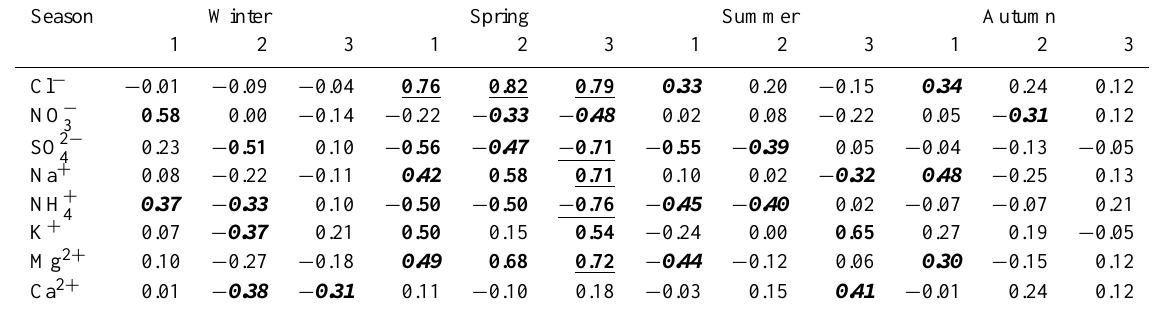
Table 4. Inorganic ions and their correlation with the biomarkers were examined. Pearson coefficient ( r) was used in order to determine the correlation between the measured biomarkers and the inorganic ions during each season. Arabitol (1), Mannitol (2), Ergosterol (3).